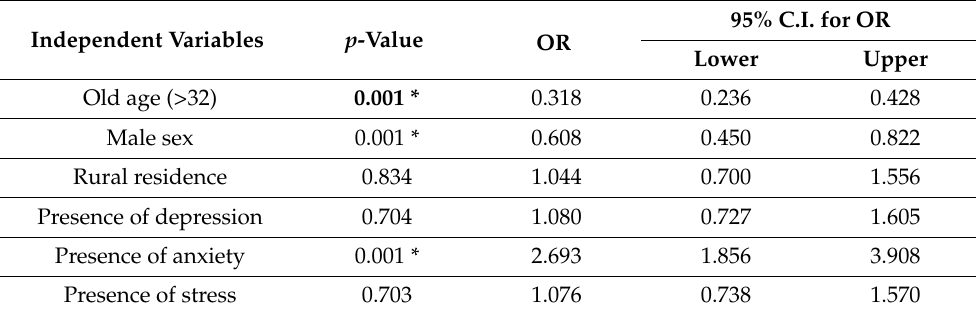
Table 6. Multivariable binary logistic regression analysis for prediction of risk factors associated with no follow-up of chronic diseases during the COVID-19